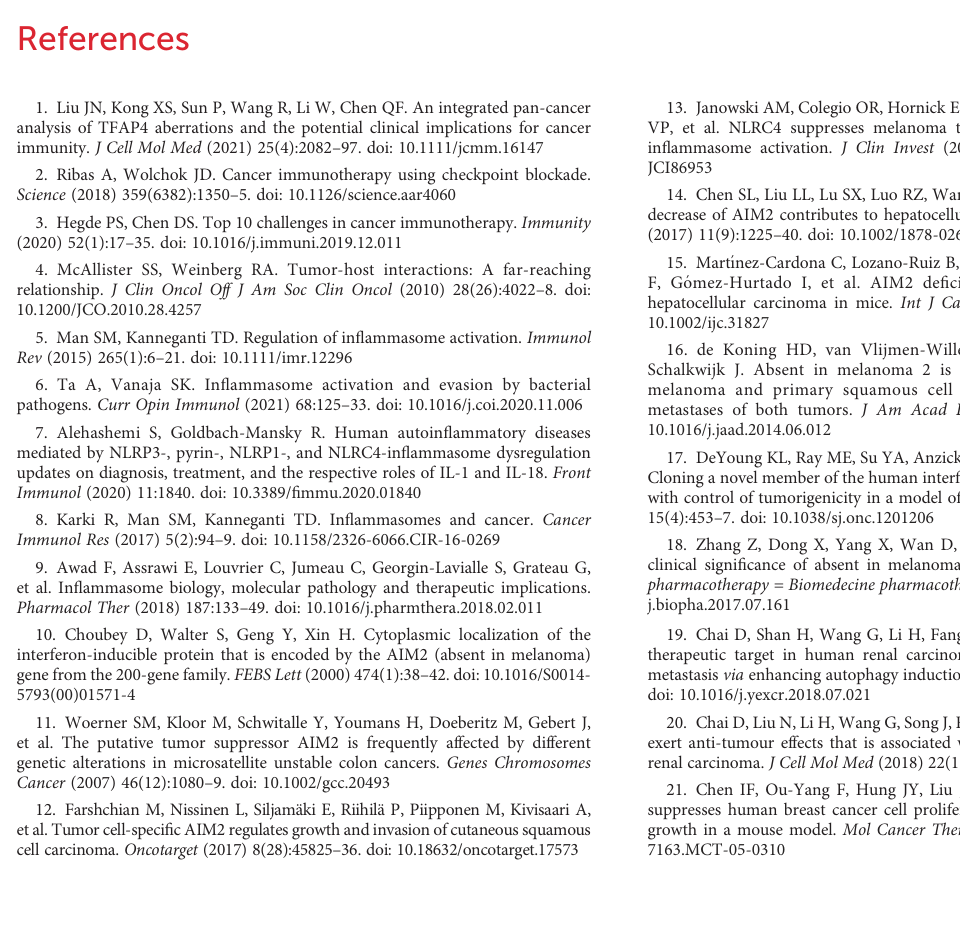
SUPPLEMENTARY FIGURE 1 Pan-cancer expression levels of the AIM2 in fl ammasomes score at different stages. SUPPLEMENTARY FIGURE 2 Kaplan-Meier survival curves of disease-speci fi c survival in patients with cancer with high versus low expressions of the AIM2 in fl ammasomes. SUPPLEMENTARY FIGURE 3 Kaplan-Meier survival curves of overall survival in patients with cancer with high versus low expressions of the AIM2 in fl ammasomes. SUPPLEMENTARY FIGURE 4 Kaplan-Meier survival curves of progression-free interval in patients with cancer with high versus low expressions of the AIM2 in fl ammasomes. SUPPLEMENTARY FIGURE 5 Correlation of the AIM2 in fl ammasomes scores with the immune scores. SUPPLEMENTARY FIGURE 6 Correlation of the AIM2 in fl ammasomes scores with the tumor immune dysfunction and exclusion scores. SUPPLEMENTARY FIGURE 7 Expression of the marker genes in different cells in the Kidney renal clear cell carcinoma tumor microenvironment. SUPPLEMENTARY FIGURE 8 The graphical abstract of the AIM2 in fl